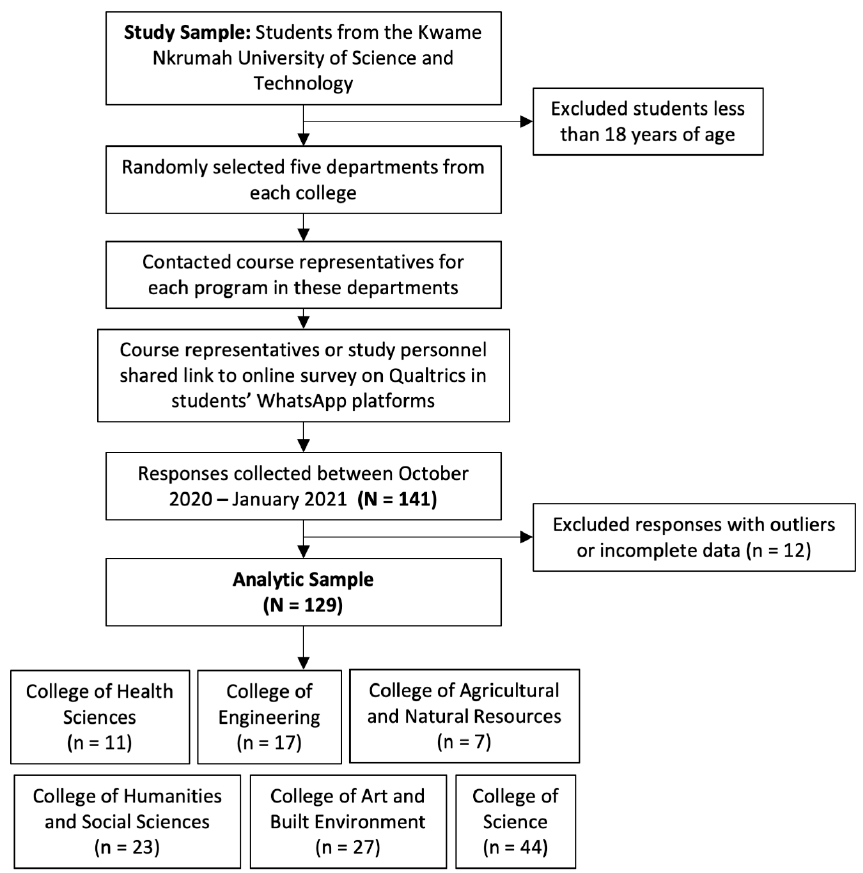
Figure 1. Flowchart of study design.